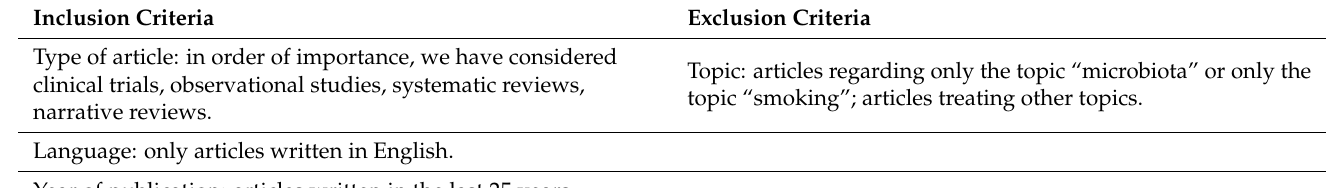
Table 1. List of inclusion and exclusion criteria. Inclusion Criteria Exclusion